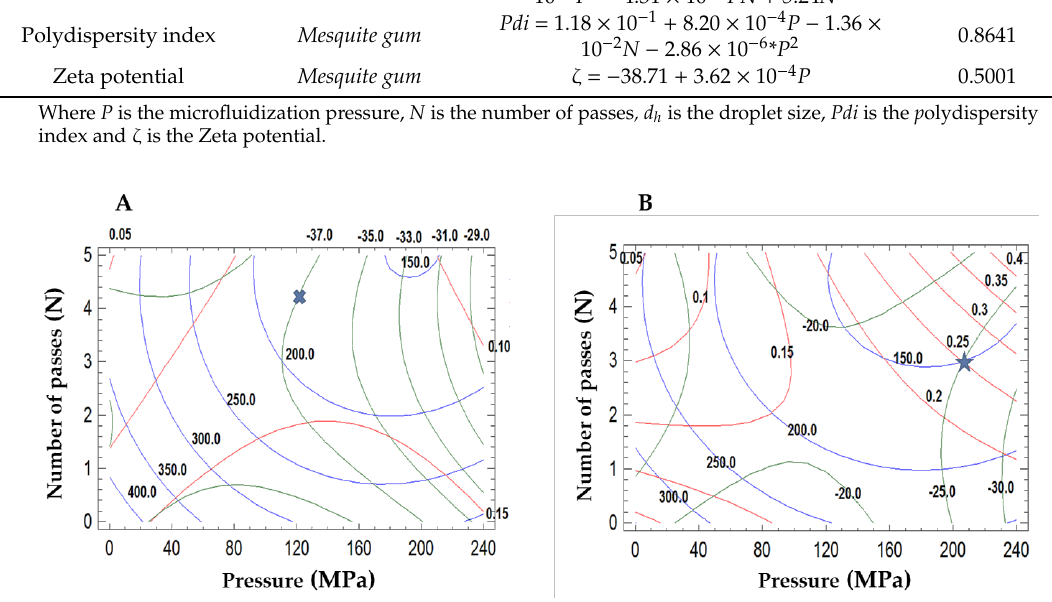
Figure 1. Response surface contour plots of the effects of the pressure and number of passes of microfluidization. ( A ) Mesquite gum emulsions, and ( B ) OSA-starch emulsions. Line red ( − ) polydispersity index, line blue ( − ) mean droplet size, and line green ( − ) zeta potential. Crossmark and star are the optimized conditions.